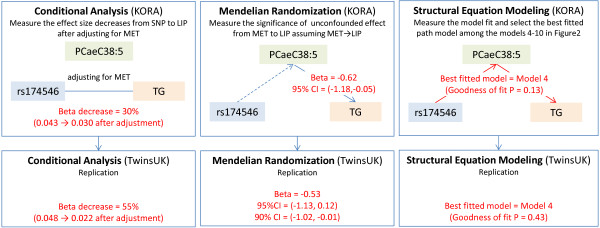
Three different statistical analyses to test the hypothesis that a metabolite mediates the FADS1 → TG pathway. The rs174546-T allele in FADS1 locus is associated with both triglycerides and a small molecule metabolite, PC ae C38:5. We have tested the hypothesis that a metabolite mediates the lipid pathway using three different statistical approaches. The conditional analysis (left) confirmed that the effect size of rs174546 on triglyceride decreased conditional on PC ae C38:5 in both KORA and TwinsUK cohorts (top and bottom). The MR (middle) estimated a statistically significant causal effect of PC ae C38:5 on triglyceride, which however was not replicated in TwinsUK at 5% significance level, perhaps due to the small sample size (KORA = 1,797 and unrelated TwinsUK = 845). The SEM (right) showed that out of all possible models tested, the model 4 (rs174546 → PC ae C38:5 → trycliceride) was the best fitted one in both cohorts.